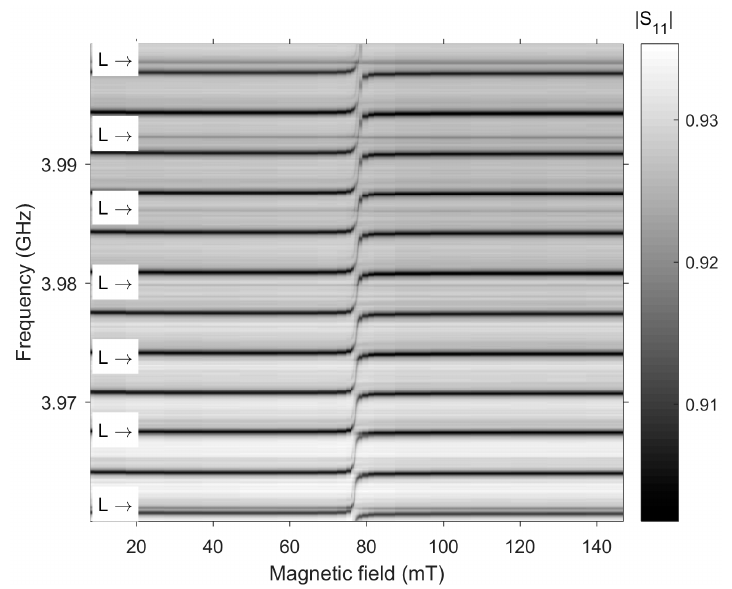
Figure 3. Frequency and magnetic field dependencies of | S 11 ( f , H )| for device 1. The arrows show the positions of the resonant frequencies of the longitudinal (L) AW, three of which correspond to the frequencies in the inset in Figure 2.